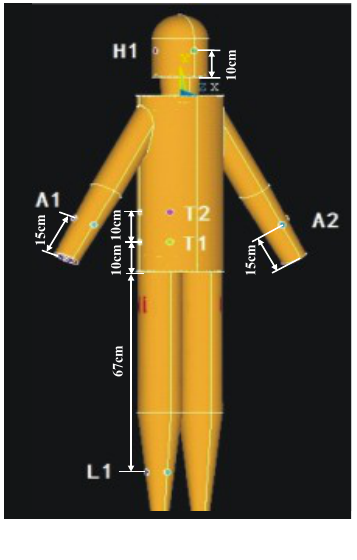
Figure 4. The electrode distribution over the whole body